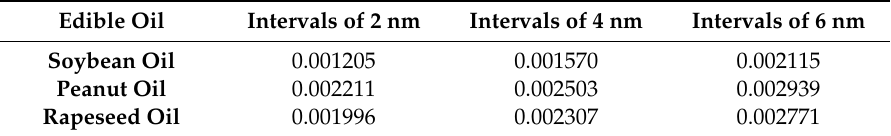
Table 1. Mean values of variance of the three kinds of oils at intervals of 2 nm, 4 nm, and 6 nm. Edible